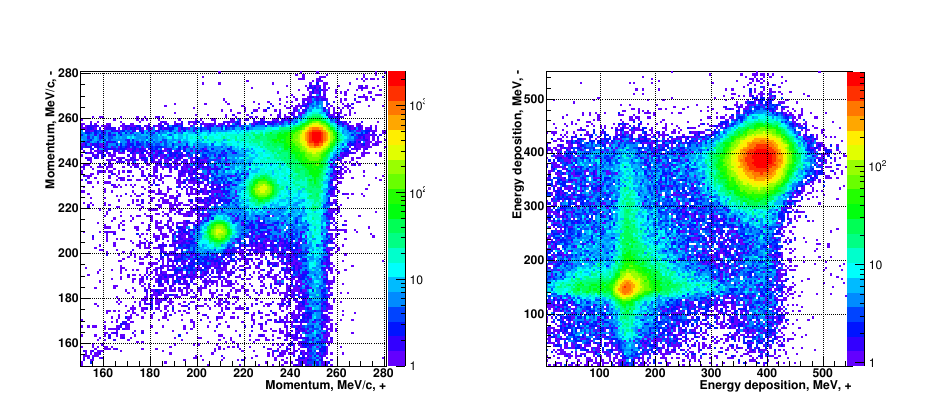
Figure 3. Distributions of collinear events of measured momenta in the DCh at energy E beam = 250 MeV (left) and energy deposition in the calorimeter at E beam = 460 MeV